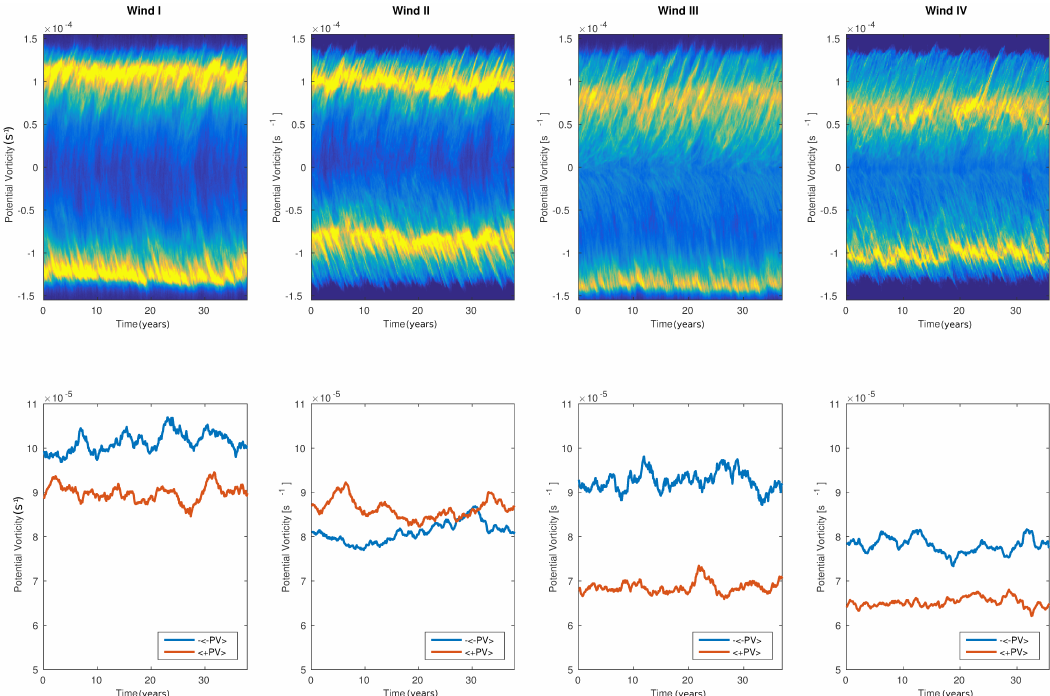
Figure 3. Temporal evolution of the distribution of surface pseudo PV ( Q 1 ) from the simulations with different wind stress formulations I – IV . The northern 20% and southern 20% of the domain have been excluded from these statistics in order to highlight the asymmetry concentrated around the inter-gyre jet. Temporal evolution of the distribution of potential vorticity ( up ) and of the mean positive and (minus) mean negative potential vorticity ( down